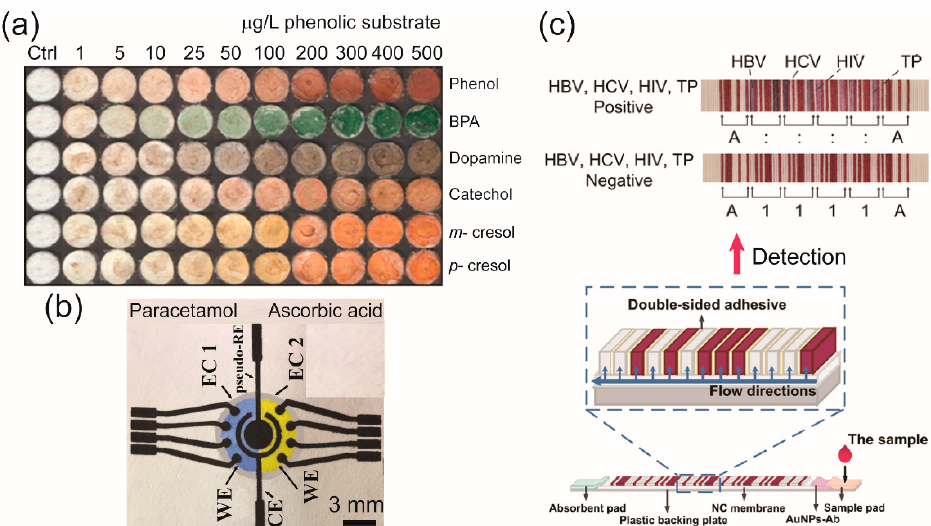
Figure 1. Represented microfluidic paper-based analytical devices (µPADs) for high-throughput screening. ( a ) The µPADs for the colorimetric detection of phenolic compounds. Reproduced with permissionfromtheauthorsof[24]. Copyright2012, AmericanChemicalSociety. ( b )Theelectrochemical (e)- µ PADs for multiplexed analytical detections of paracetamol, ca ff eine, and ascorbic acid in drugs. Reproduced with permission from the authors of [25]. Copyright 2018, Elsevier B.V. ( c ) Lateral flow assay (LFA) that can be used for detecting four biomarkers (hepatitis B virus (HBV), hepatitis C virus (HCV), human immunodeficiency virus (HIV), and Treponema pallidum (TP)), simultaneously. Reproduced with permission from the authors of [26]. Copyright 2017 under the terms and conditions of the Creative Commons